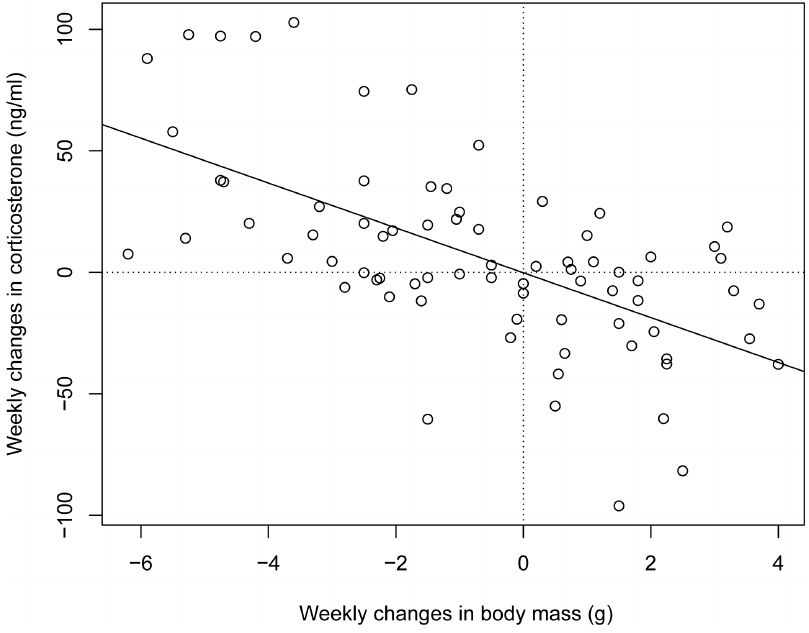
Figure 4. Relationship between the weekly changes in body mass and corticosterone levels in all experimental house sparrows. Note that individuals are represented with multiple points. The line represents the model fit of the fixed model that accounts for the repeated nature of the data. doi:10.1371/journal.pone.0110564.g004 PLOS ONE |